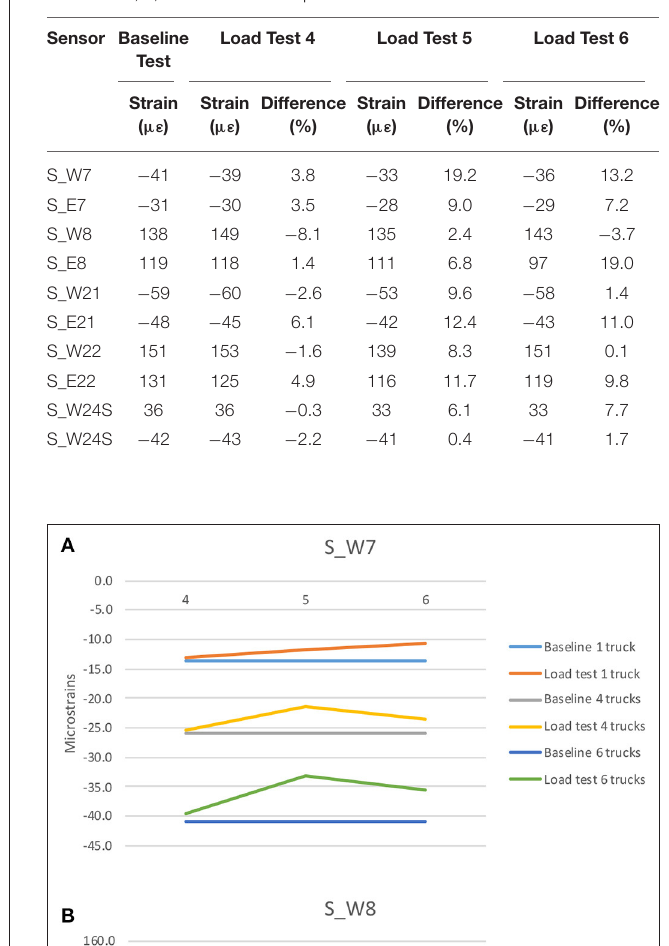
TABLE 5 | Comparison of peak baseline strain for key sensors to peak strains for load tests 4, 5, and 6 for six truck passes.